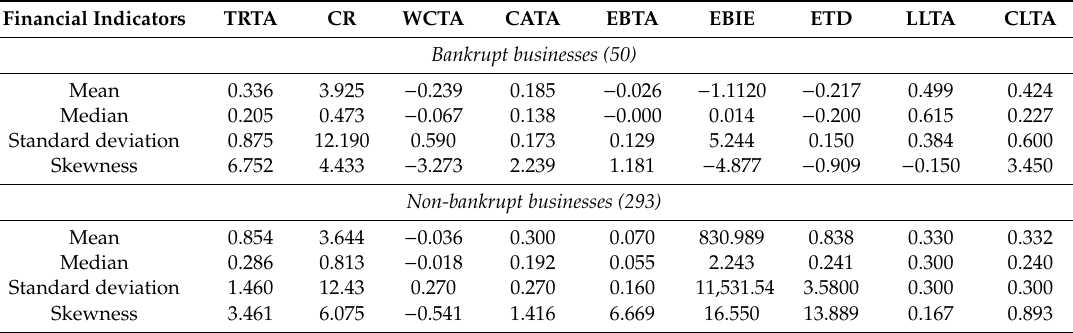
Table 1. Descriptive statistics for bankrupt and non-bankrupt businesses.